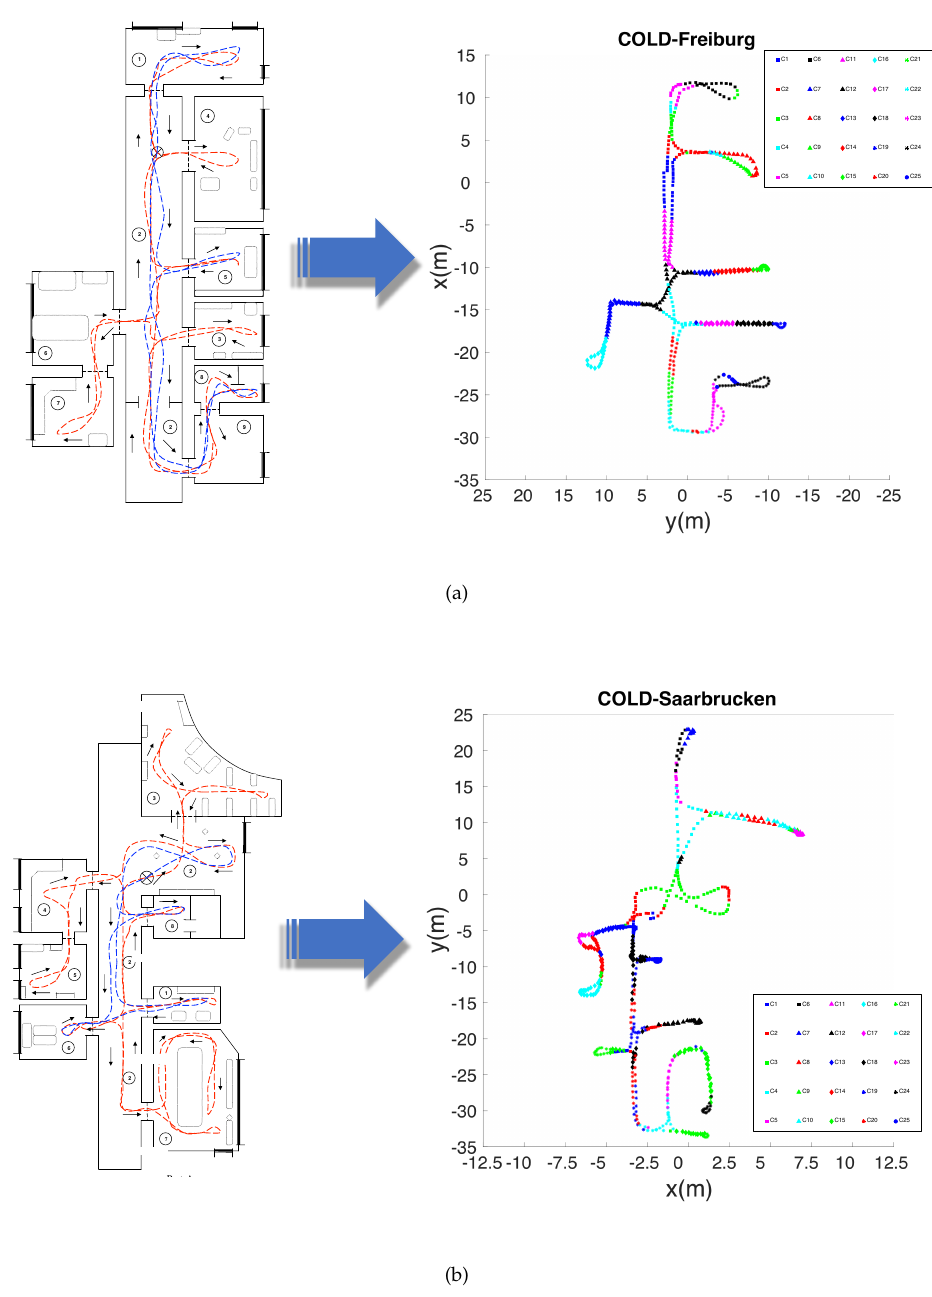
Figure 15. Clusters obtained in the COLD environments through the use of Spectral clustering and gist description. ( a ) Freiburg and ( b ) Saarbrücken